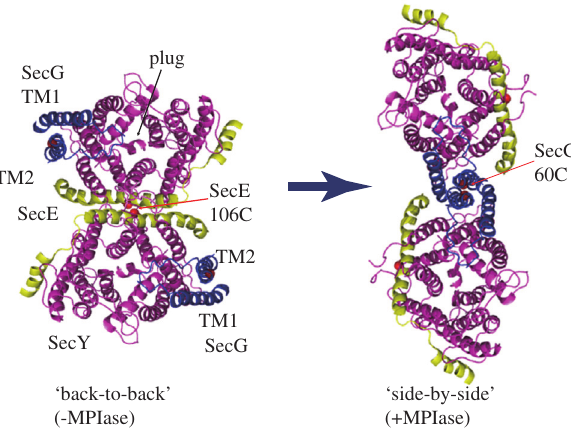
Figure 5 MPIase modulates the dimer orientation of SecYEG. The structure of the SecYEG protomer (48) was modeled into back- to-back (left) and side-by-side (right) dimers. SecY, purple; SecE, yellow; SecG, blue. The positions of SecE 106C and SecG 60C are shown by red circles. The positions of TM 1 and 2 of SecG, and the plug domain in SecY (64) are also